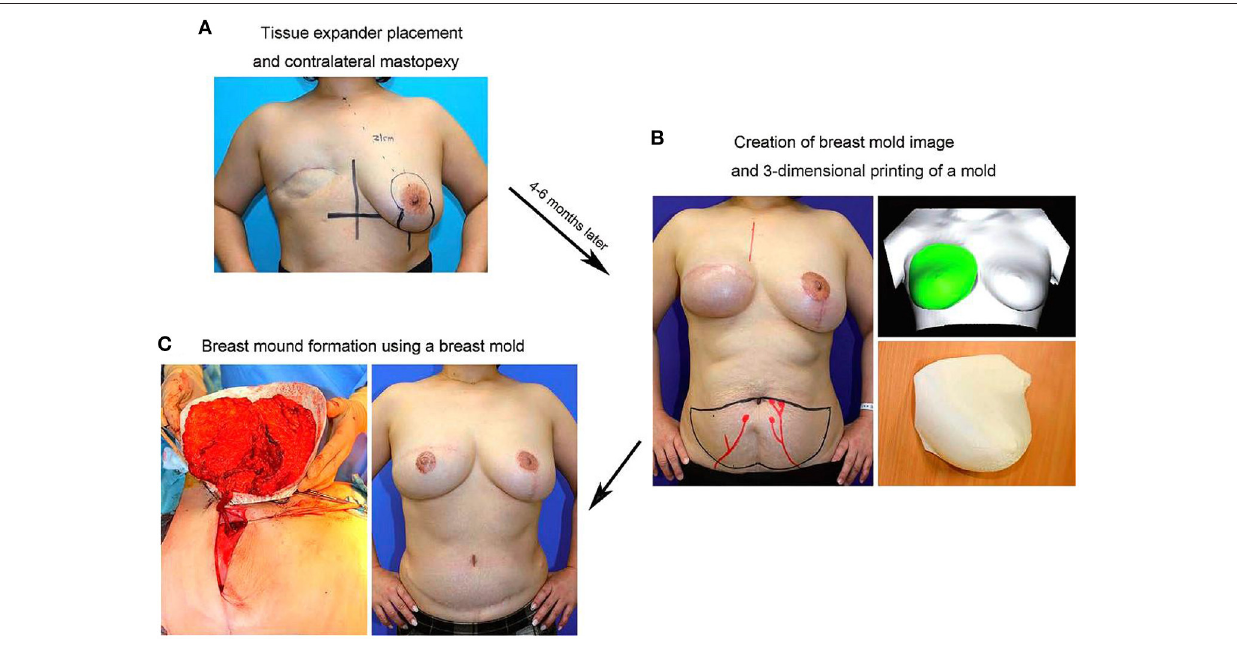
FIGURE 6 | (A) In the initial surgery, TE placement in the affected breast and mastopexy of the contralateral breast using the vertical scar technique are performed. (B) Four to six months postoperatively, a 3D bilateral breast imaging is performed after confirming that the shape of the contralateral breast is somewhat stabilized, and a 3D-printed breast mold is created based on the mirror image of the shape of the contralateral breast. (C) In DIEP flap surgery, the direction of the flap and volume of graft tissue are determined using the breast mold. Copyright © 2017, Copyright © 2017 The Authors. Published by Wolters Kluwer Health, Inc. on behalf of The American Society of Plastic Surgeons